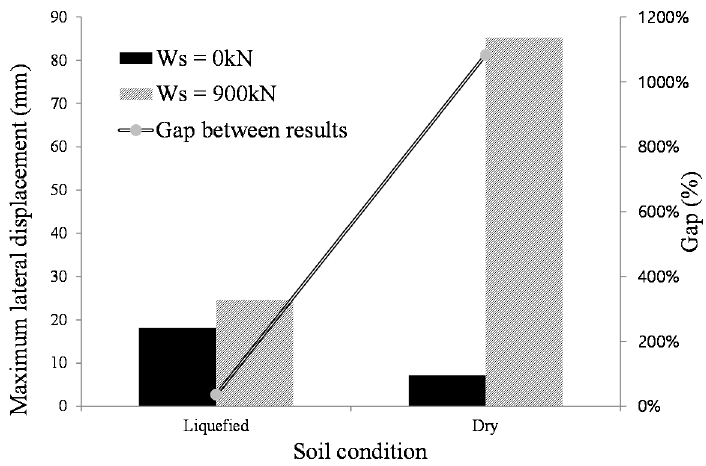
Figure 18. E ff ect of kinematic force in di ff erent soil condition under earthquake.